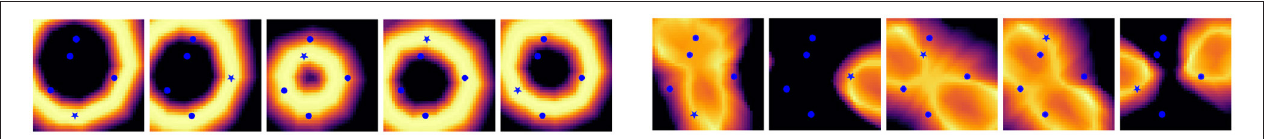
FIGURE 2 | Magnitude of the difference in predicted score for the positive and negative classes for a comparison between a 5-object configuration and a perturbed version of this configuration where one object is displaced over the 2d-plane. Value displayed is score + − score − , where score + corresponds to the score of the logits of the positive class as output by the model, and score _ corresponds to the logits of the negative class. Left row is with RDS layers and right row is with MPGNN. For each row, the displaced object’s position is indicated with a blue star, the other ones with a blue dot. The sizes, colors, orientations and shapes of the objects are not represented. Bright yellow means the model assigns the positive class to the configuration where the displaced object would be placed here, black means the negative class would be assigned.